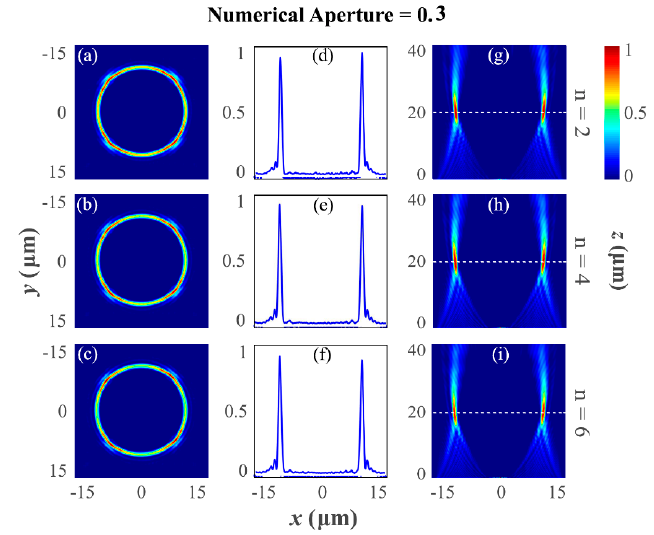
Figure 3. Far-field intensity distribution of the generated PV beams for numerical aperture NA = 0.3 and different topological charges ℓ = 2,4,and 6 for the UV wavelength λ d = 300 nm. ( a – c ) The transverse intensity distribution of the diffracted light at the designed focal plane is ∼ 20 µ m (XY- monitor). It is seen that as the value of the topological charge increases, there is no variation in the ring size, thus verifying the generation of a perfect vortex beam. ( d – f ) indicate the full-width half-maximum of the light at the focal plane. While minting the numerical aperture NA = 0.3, the focal length of the lens is decided as 1/3 times lower than the actual focal length. ( g – i ) The required non-diffracting type field behavior and formation of constant ring radius with maximum intensity at the desired focal plane.